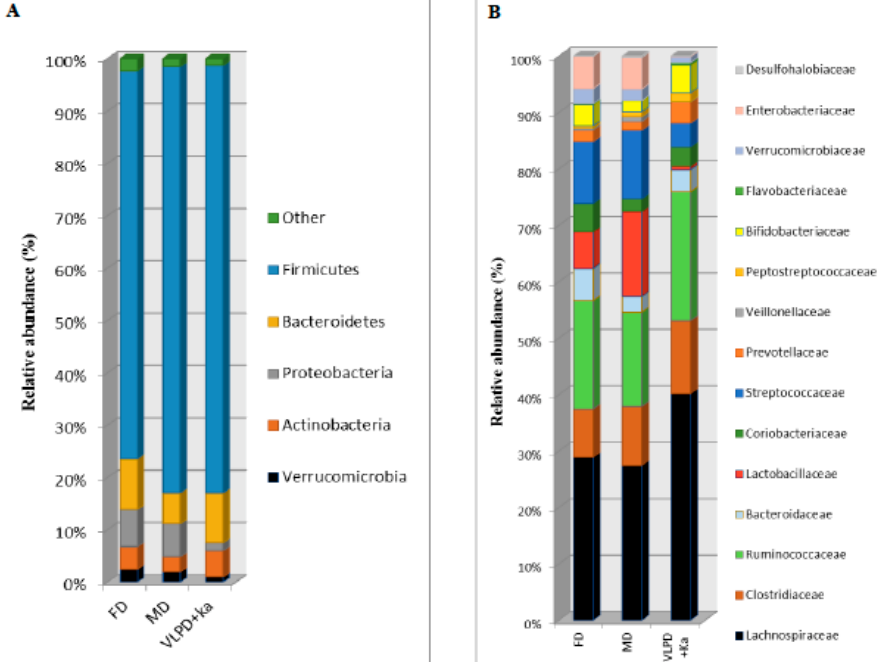
Figure 2. Bacterial phyla and families associated to dietary regimens in intestinal microbiota of chronic kidney disease (CKD) patients. Average of relative abundance (%) of bacterial phyla ( A ) and families ( B ) which were found in the fecal samples of patients with free diet (FD), Mediterranean diet (MD), or very low protein diet supplemented with alphaKappa (VLPD + Ka). Only phyla showing statistical differences ( p < 0.05) in at least one dietary regimen were reported.